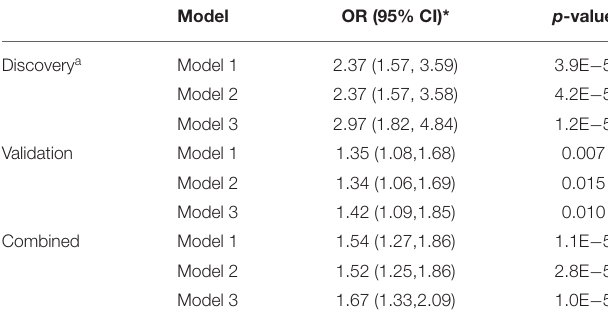
TABLE 5 | Odds ratio of rs13019803 on the risk of type A